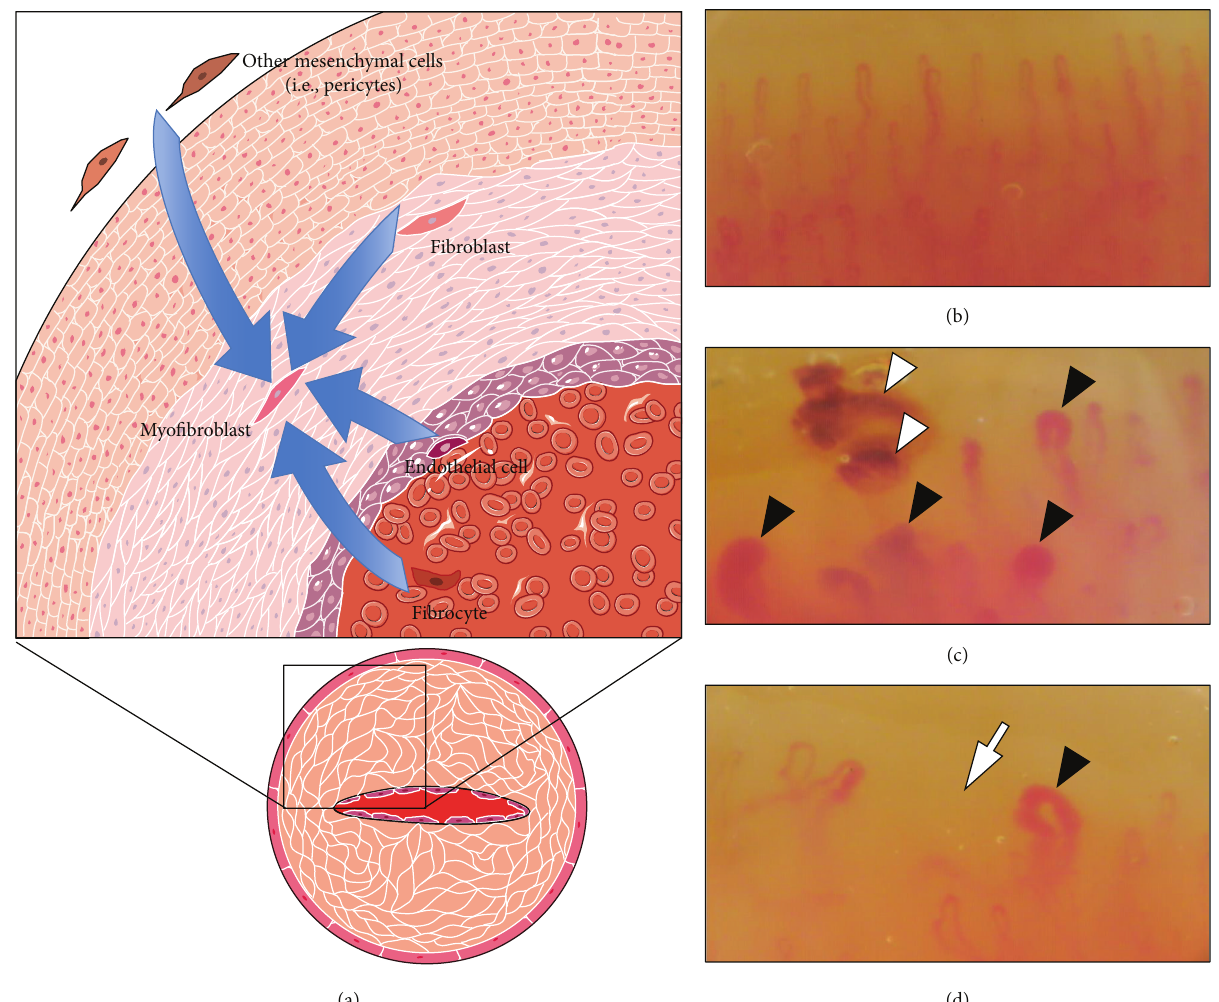
Figure 1: Vascular remodelling and capillaroscopic pattern in Systemic Sclerosis (SSc). (a) Stenoocclusive remodelling in SSc microvas- culature (bottom right) is believed to result from an abnormal reparative attempt triggered by chronic endothelial damage, which drives intima-media hyperplasia and increased ECM production within the vessel wall. Mesenchymal cells, specifically myofibroblasts with a highly secretory phenotype, are the main final effectors responsible for these structural changes. Myofibroblasts in SSc vessels can originate from multiple cellular sources (upper left), either of mesenchymal origin, such as pericytes or fibroblast, or of nonmesenchymal origin, such as endothelial cells. (b)–(d) Capillaroscopic pattern in normal subjects (b) and scleroderma patients at magnification 200x ((c): “active” SSc pattern; (d): “late” SSc pattern). Note the heterogeneity in the architecture and morphology of SSc capillaries with frequent ectasias (black arrowheads). In the “active” scleroderma pattern there are plenty of giant capillaries (i.e., more than 50 𝜇 m of diameter) and microhaemorrhages (white arrowheads), with mild loss of capillaries. In the “late” scleroderma pattern giant capillaries and microhaemorrhages are less frequent, but a severe loss of capillaries is evident, with extensive avascular areas (white